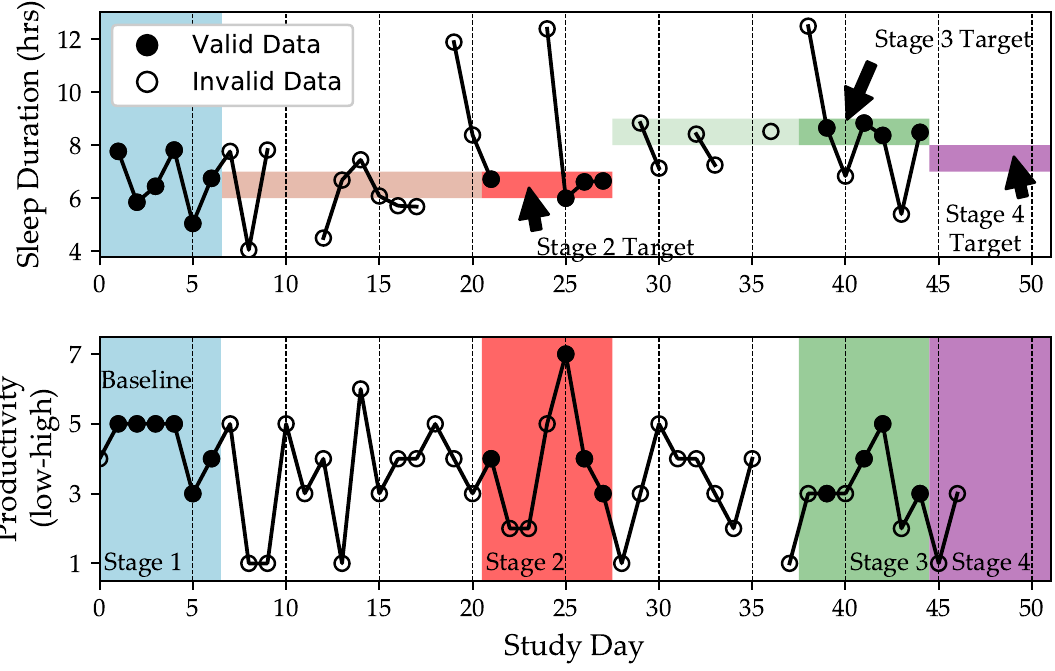
Figure 5. Example of a participant’s self-experiment. The ( top panel ) shows filled circles where the independent variable, sleep duration, was reported within the study range requirements, and empty circles where it was reported as outside the required range. The ( bottom panel ) shows all reports for the outcome variable: self-reported productivity. The shaded areas (blue, red, green, and purple) mark the four stages of the study, only the first three of which met the requirement of “at least four days” of data (darkened circles). In the top panel, we can see that these shaded areas also display the bounds of target behavior (except for the baseline stage, which had no target behavior and therefore no bounds). Only valid data are used in